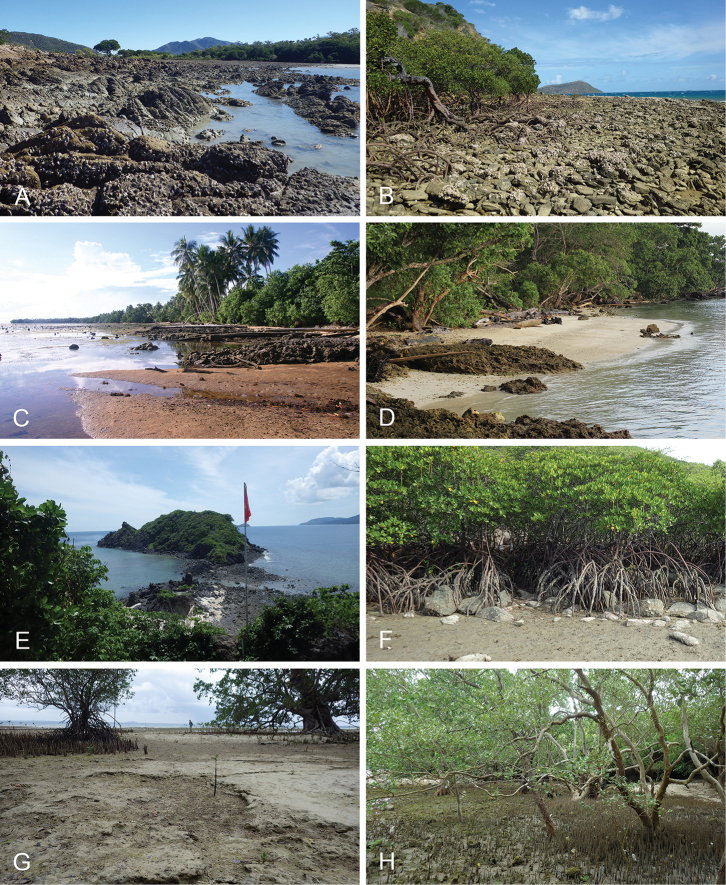
Habitats, Peronia
verruculata (unit #1) A Australia, Queensland, rocky shore nearby a small and dense Rhizophora mangrove patch (st 113) B New Caledonia, coastal rocky mangrove (st KM 537) C Papua New Guinea, New Ireland, mixed hard platform and seagrass bed at outlet of rivulet (st KM 05) D Papua New Guinea, Madang, limestone rocky intertidal (st PM 12) E Vietnam, mangrove patch with many big flat rocks outside (st 236) F Vietnam, coral rubble near small Rhizophora sandy and muddy mangrove (st 238) G Philippines, Bohol, coral rubble with sand and algae, near Sonneratia (st 202) H sandy, open Avicennia forest, right by the shore (st 181).